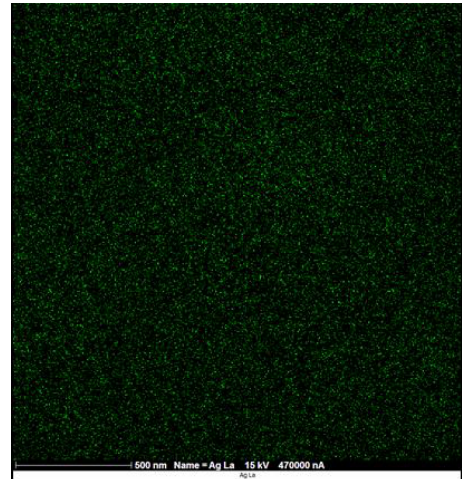
Fig. 4. EDS of nanocatalyst